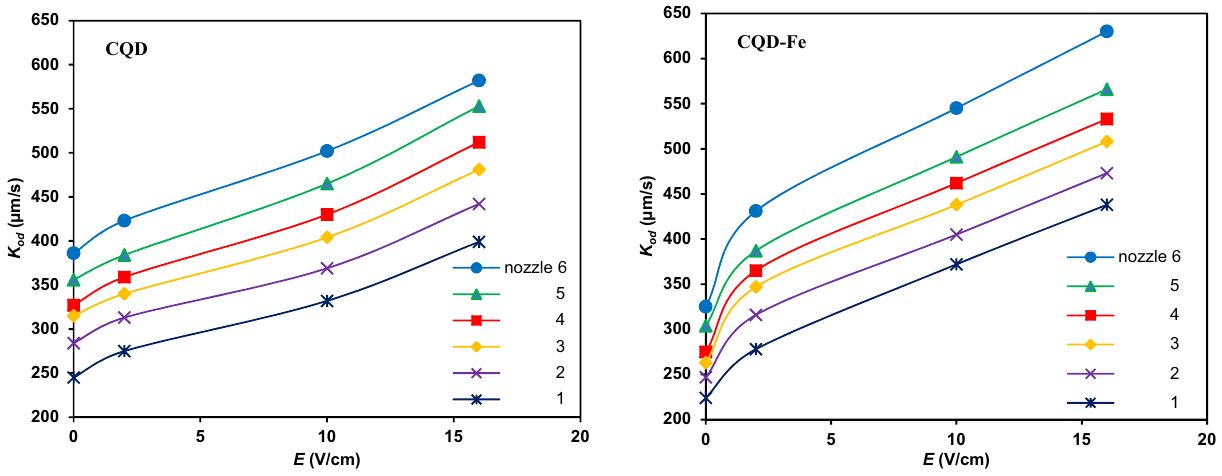
Figure 9. Mass transfer coefficient versus electric field strength under frequencies of 150 (CQD) and 250 Hz (CQD-Fe) for different nozzles and concentrations of 0.0015 (CQD) and 0.002 wt% (CQD-Fe).